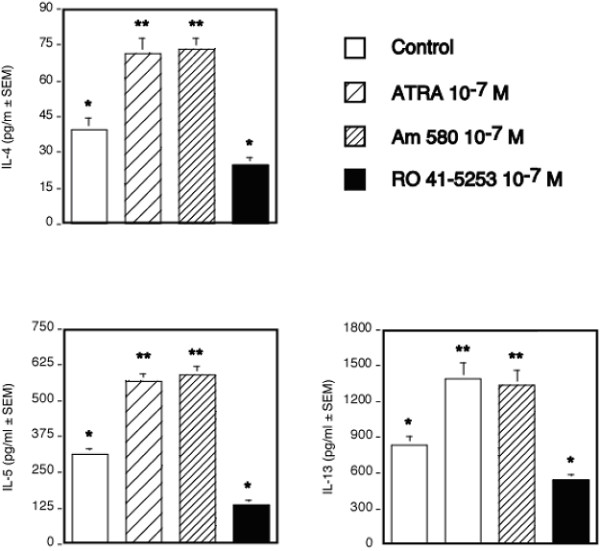
A RAR-α agonist specifically induces Th2-associated cytokine production by anti-CD3,-activated PBMC. IL-4, IL-5, and IL-13 proteins were quantitated by ELISA in supernatants of 48 h, anti-CD3,-activated PBMC treated with EtOH, ATRA (10-7 M), the RAR-α agonist, AM580 (10-7 M), or an RAR- α antagonist, RO 41-5254 (10-7 M). The values shown represent the average obtained from 4 donors ± SEM. Means that express different superscripts are significantly different by at least p < 0.02.